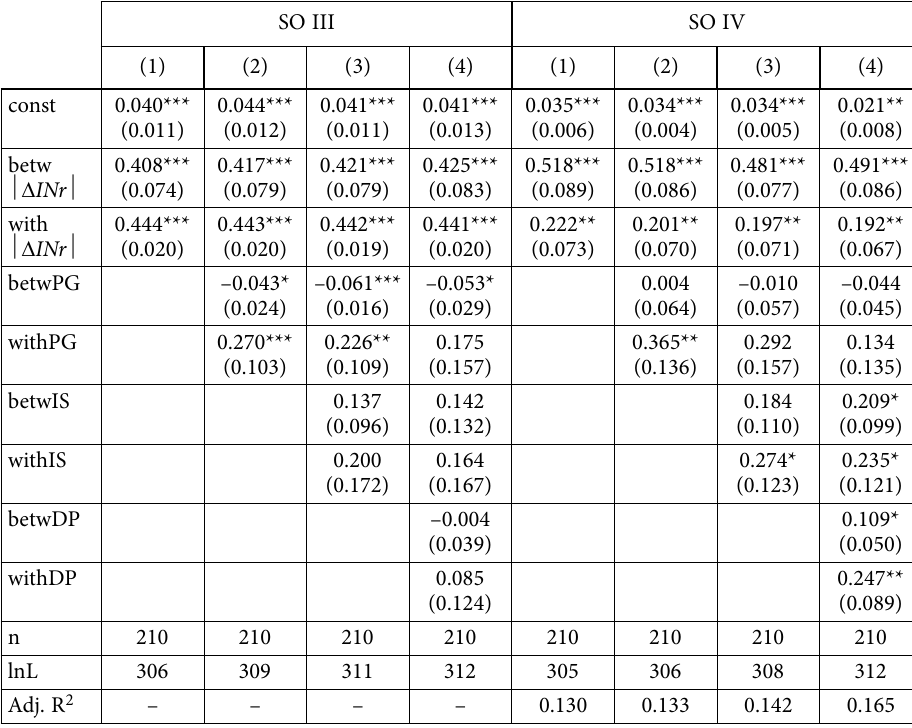
Table 5. Random-effects (GLS) estimates for III SO and pooled OLS estimates for SO IV (robust HAC standard errors, dependent variable D Pr c , t  , all var. expressed in total output shares) (source: owna calcuations using EUFADN data and EAA Eurostat